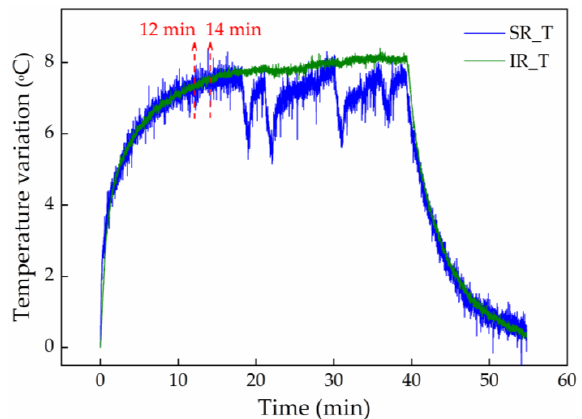
Figure 7. Thermal variation obtained during pressure relief exercises for the sensors positioned in the right scapula and ischiatic.